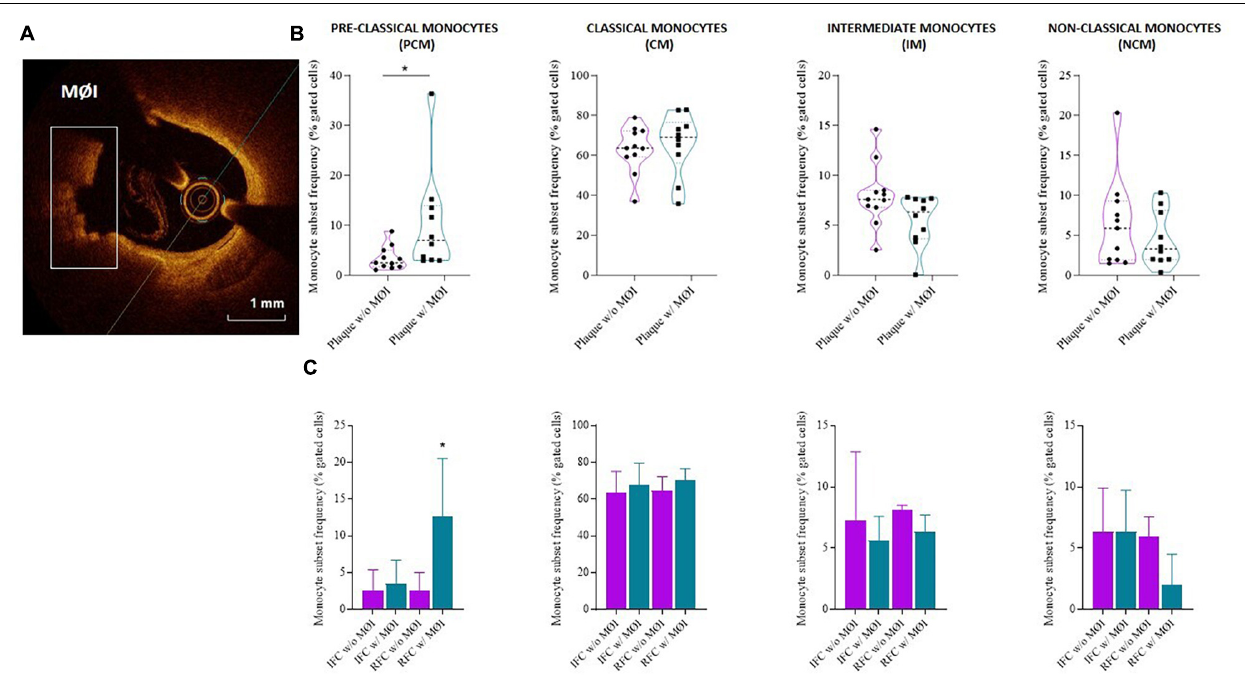
FIGURE 4 | Distribution of monocyte subsets in non-ST elevation acute coronary syndrome (NSTE-ACS) patients according to plaque erosion (IFC) or rupture (RFC) and local macrophage infiltration (MØI). (A) Representative optical coherence tomography (OCT) image of MØI. (B) Frequency of circulating monocyte subsets in NSTE-ACS patients according to OCT-MØI assessment, (C) and according to both plaque morphology (IFC versus RFC) and MØI. Data are presented for panel (B) as median and interquartile range and for panel (C) as mean ± SD; * p <